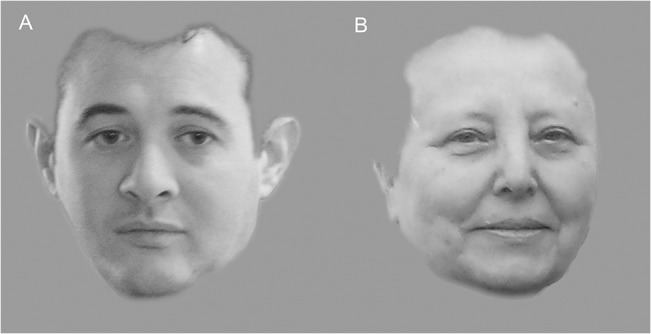
Examples of the faces used as stimuli.(A) Example of a male face personally known to patient GN. (B) Example of a female face unknown to patient GN.